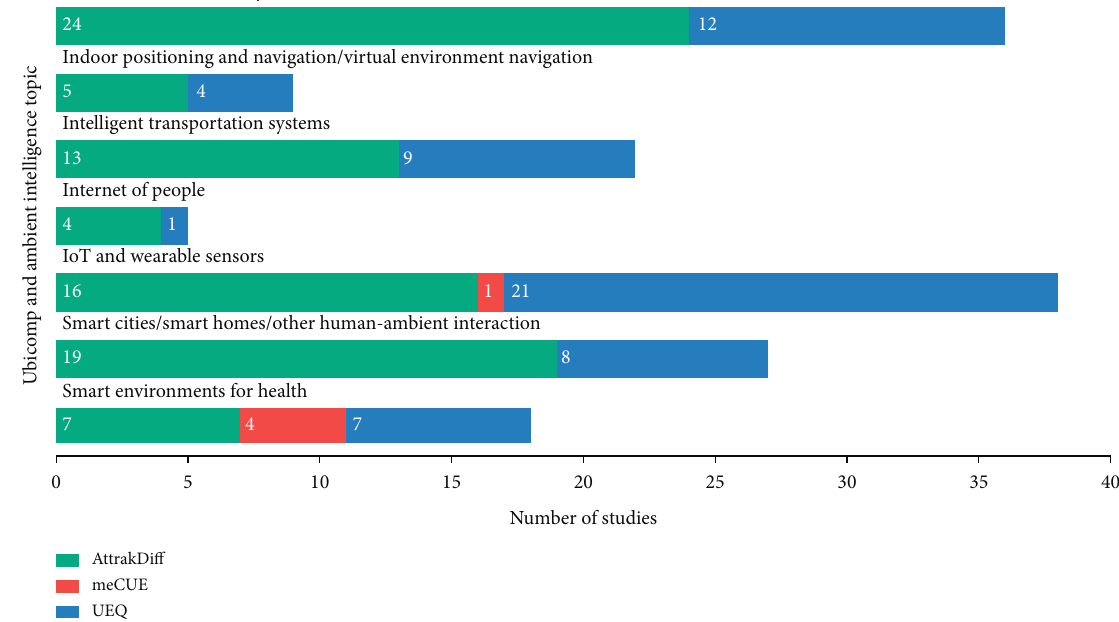
Figure 11: Number of uses of standardized questionnaires in UbiComp and ambient intelligence studies by